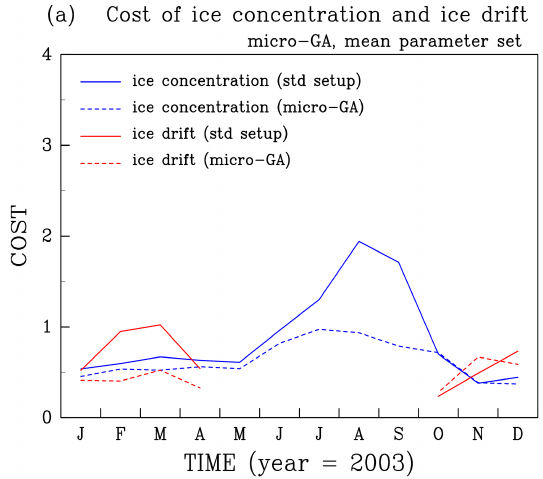
Fig. 12. The same as Fig. 7 but with the µGA optimization exper- iments (µGA – 1: population size = 5, number of possibilities of each parameter = 2 7 )